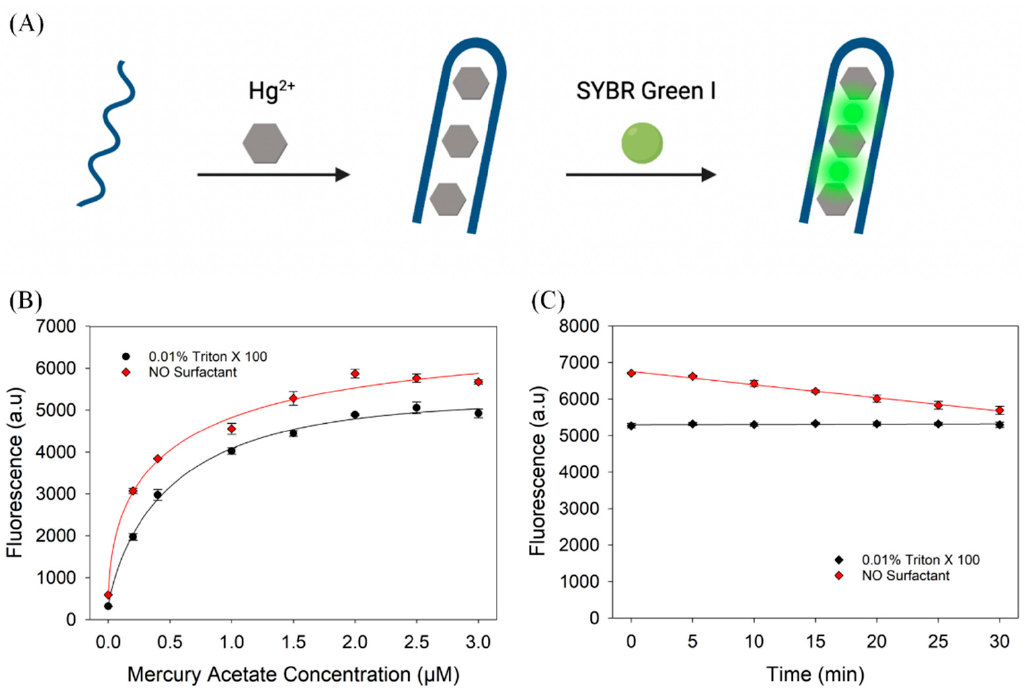
Figure 4. ( A ) A scheme of Hg 2+ binding to a thymine-rich DNA detected by SGI. Hg 2+ binds to the DNA and folds into a structure with a long duplex region, resulting in a strong SGI fluorescence. ( B ) Titration curve of 200 nM T 30 using mercury acetate with and without 0.01% Triton X-100. ( C ) Effect of Triton X-100 on signal stability of T 30 /SGI in the presence of 2 μ M Hg 2+ .